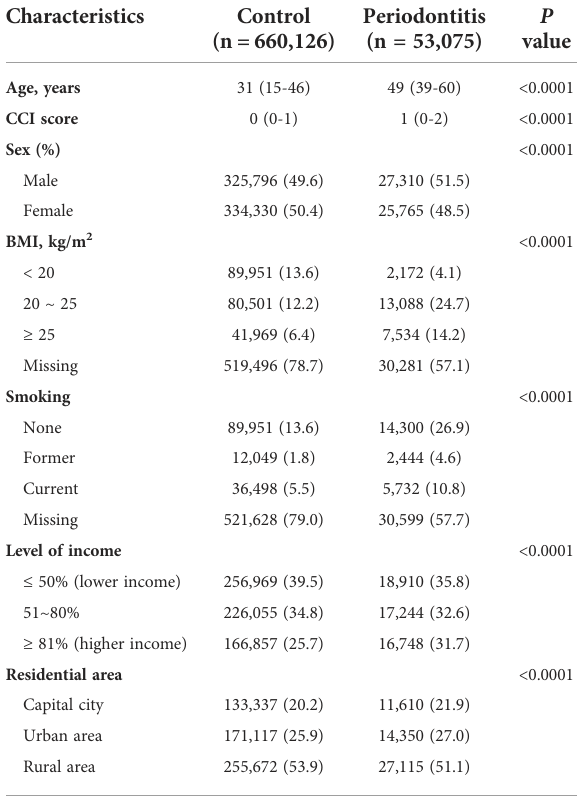
Table 1 Baseline characteristics of the study population (n =